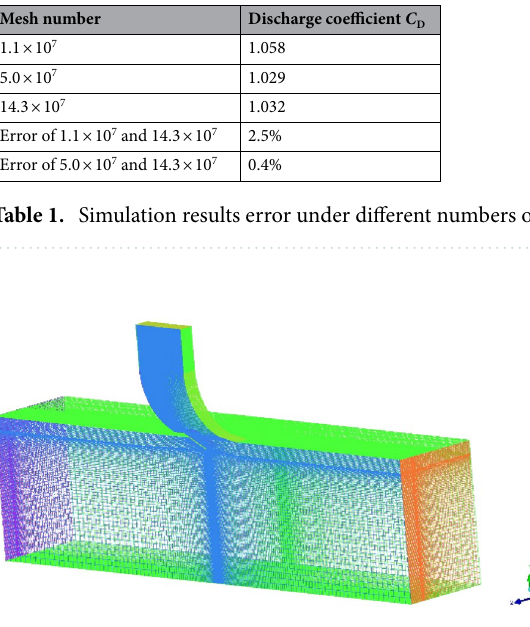
Figure 9. Structured mesh for the experimental